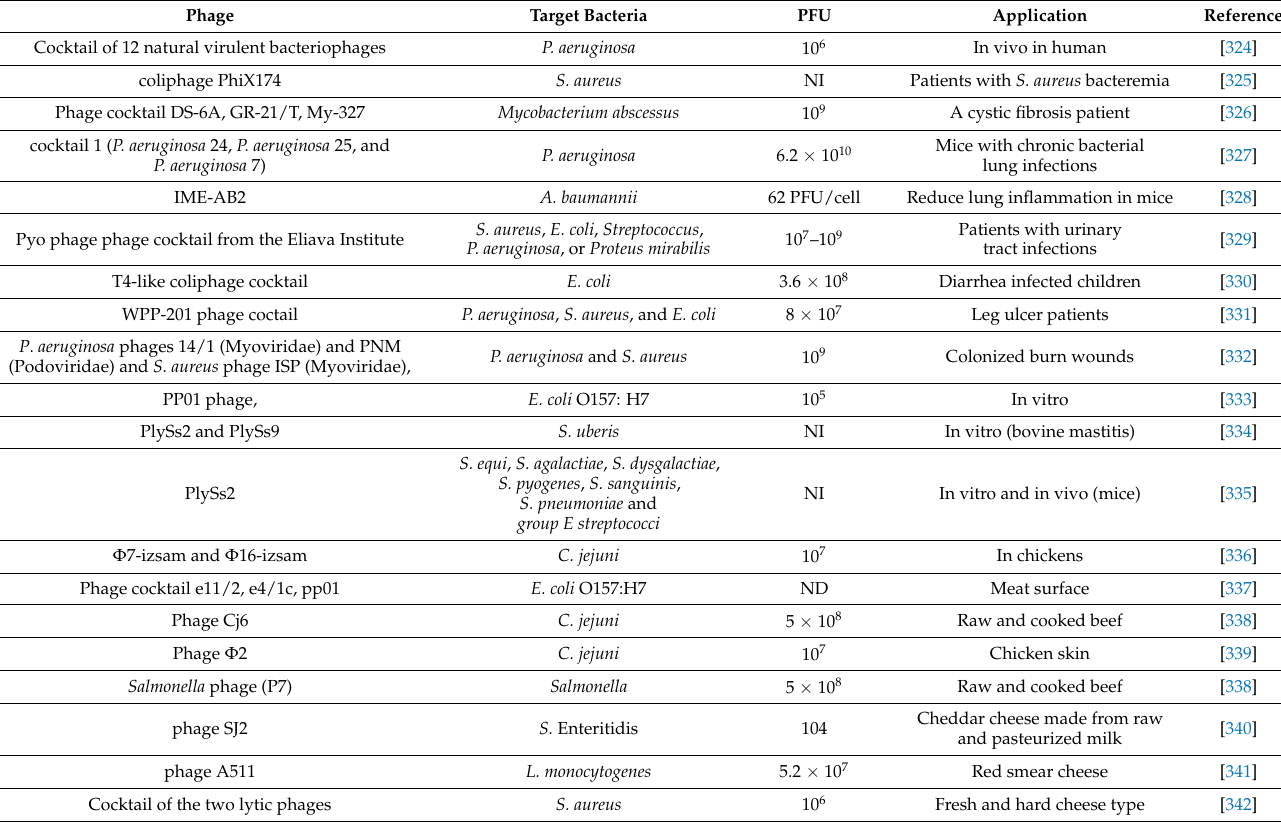
Table 4. Examples of identified phages against pathogenic